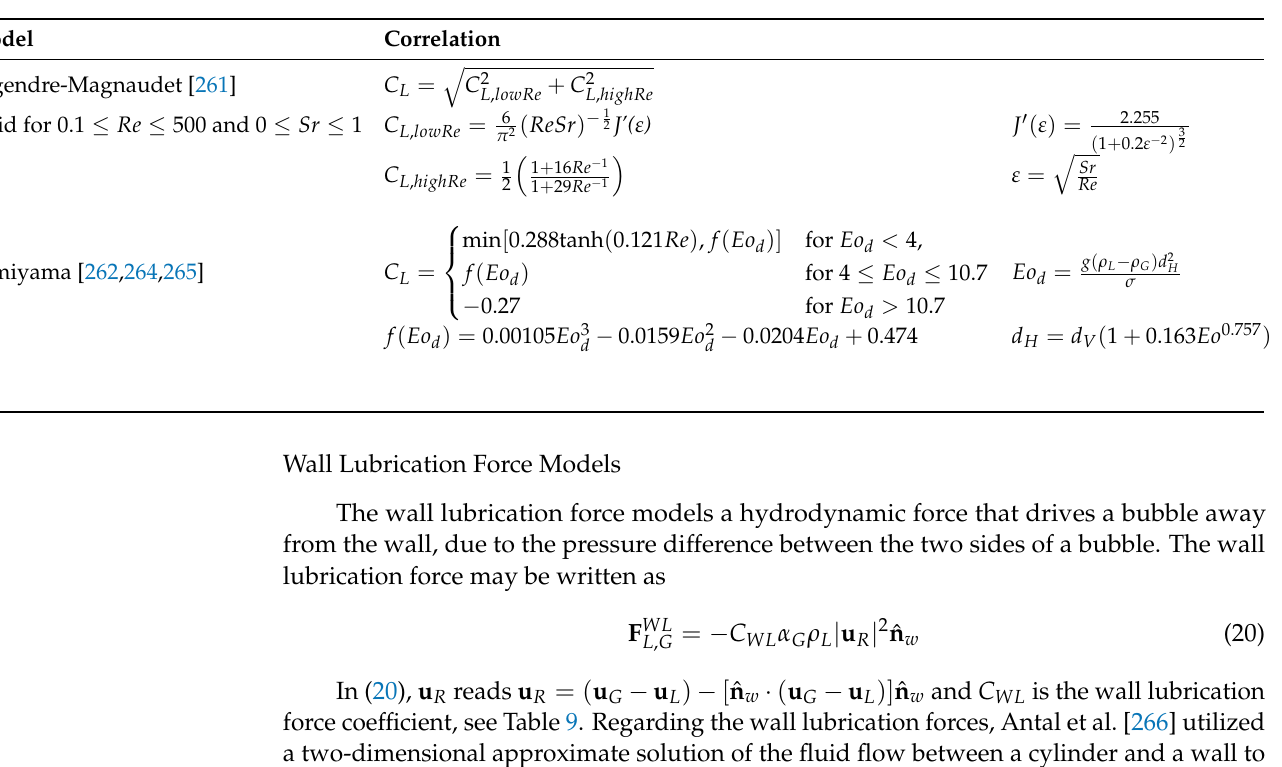
Table 8. Lift coefficient